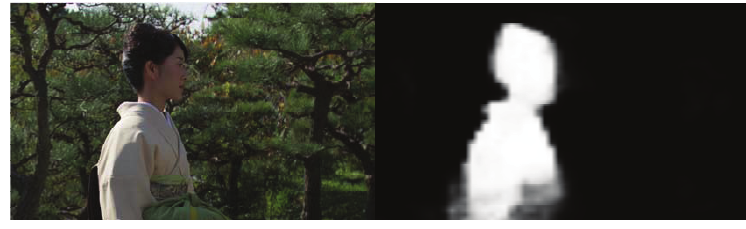
Figure 5. VS map of Basketball and Kimono